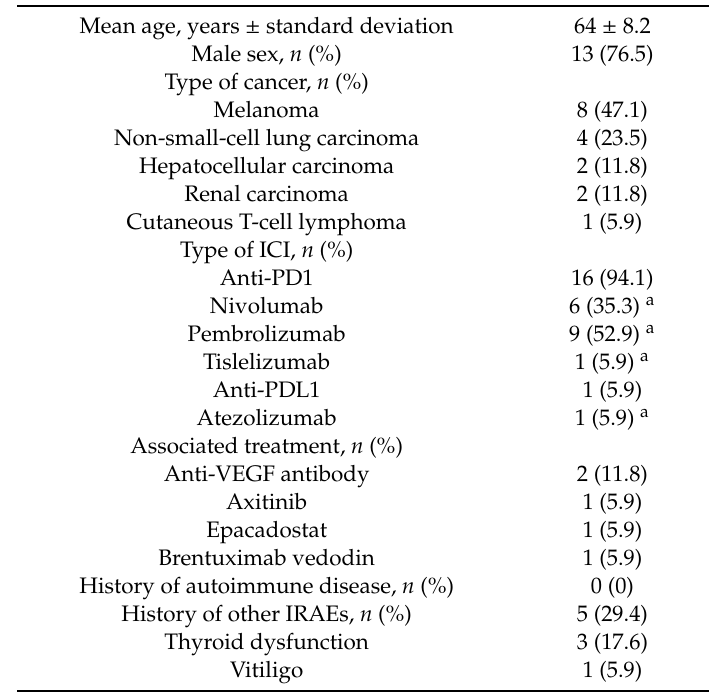
Figure 1. Selection process to include cases. PD1: programmed cell death 1 protein, PDL1: programmed cell death 1 ligand 1. Table 1. Patient characteristics ( n =